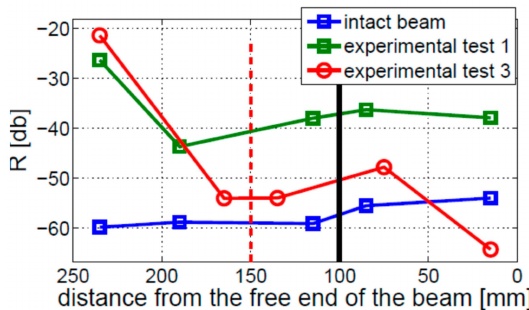
Figure 25. Level of nonlinearity estimated for the free–free beam for two different crack locations indicated by the vertical solid black (Experimental Test 1) and dashed red (Experimental Test 3)